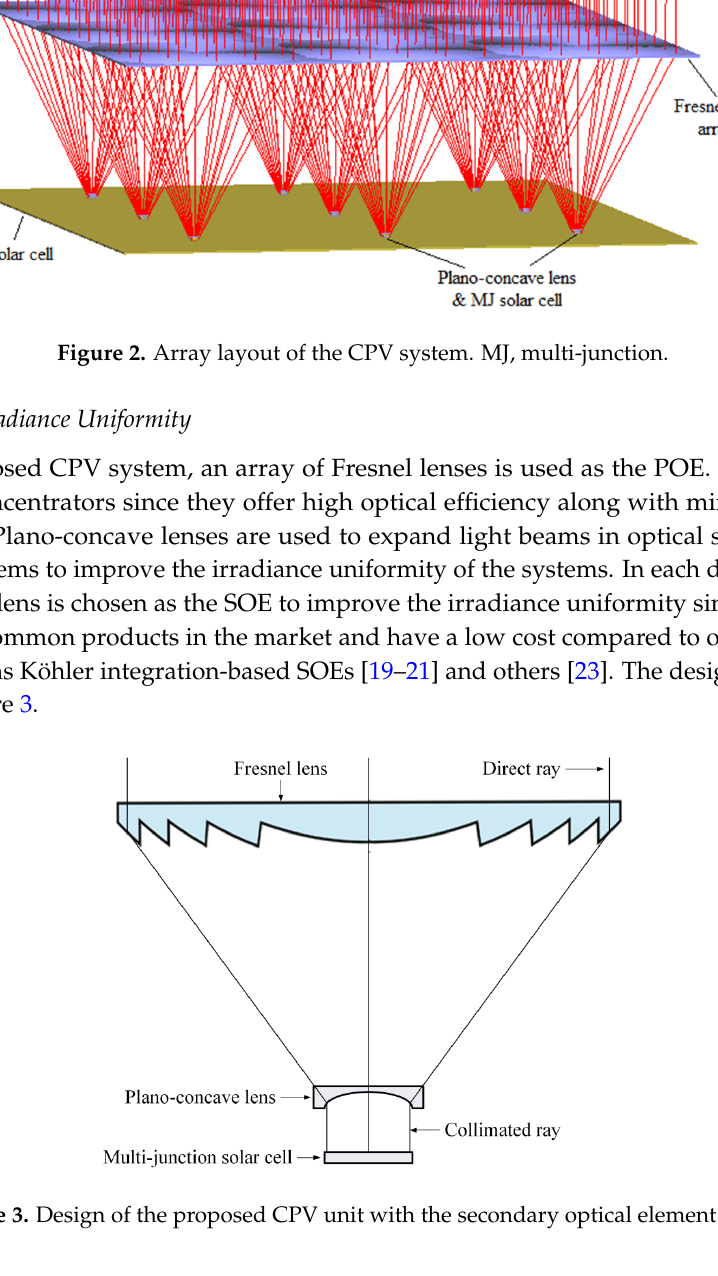
Figure 1. Design of the proposed concentrator photovoltaic (CPV) system. Si, silicon.